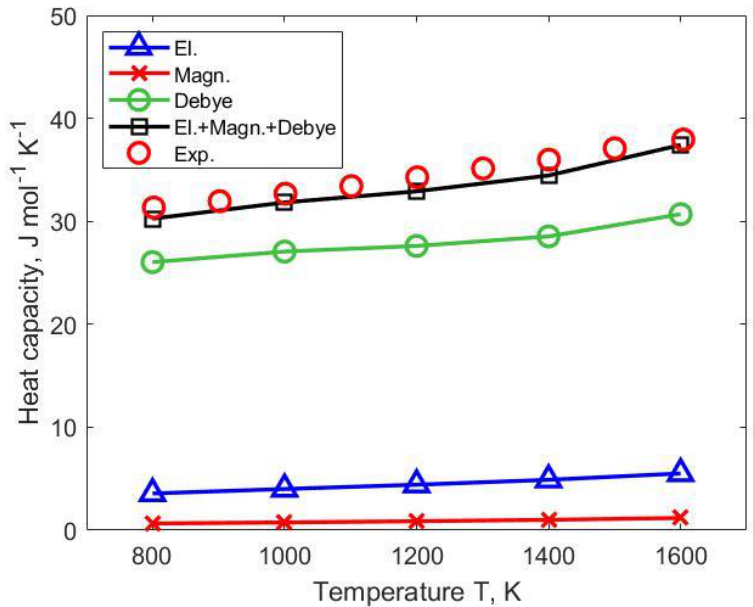
Figure 10. Isobaric heat capacity of FCC nickel as a function of temperature. Experimental data from [54].